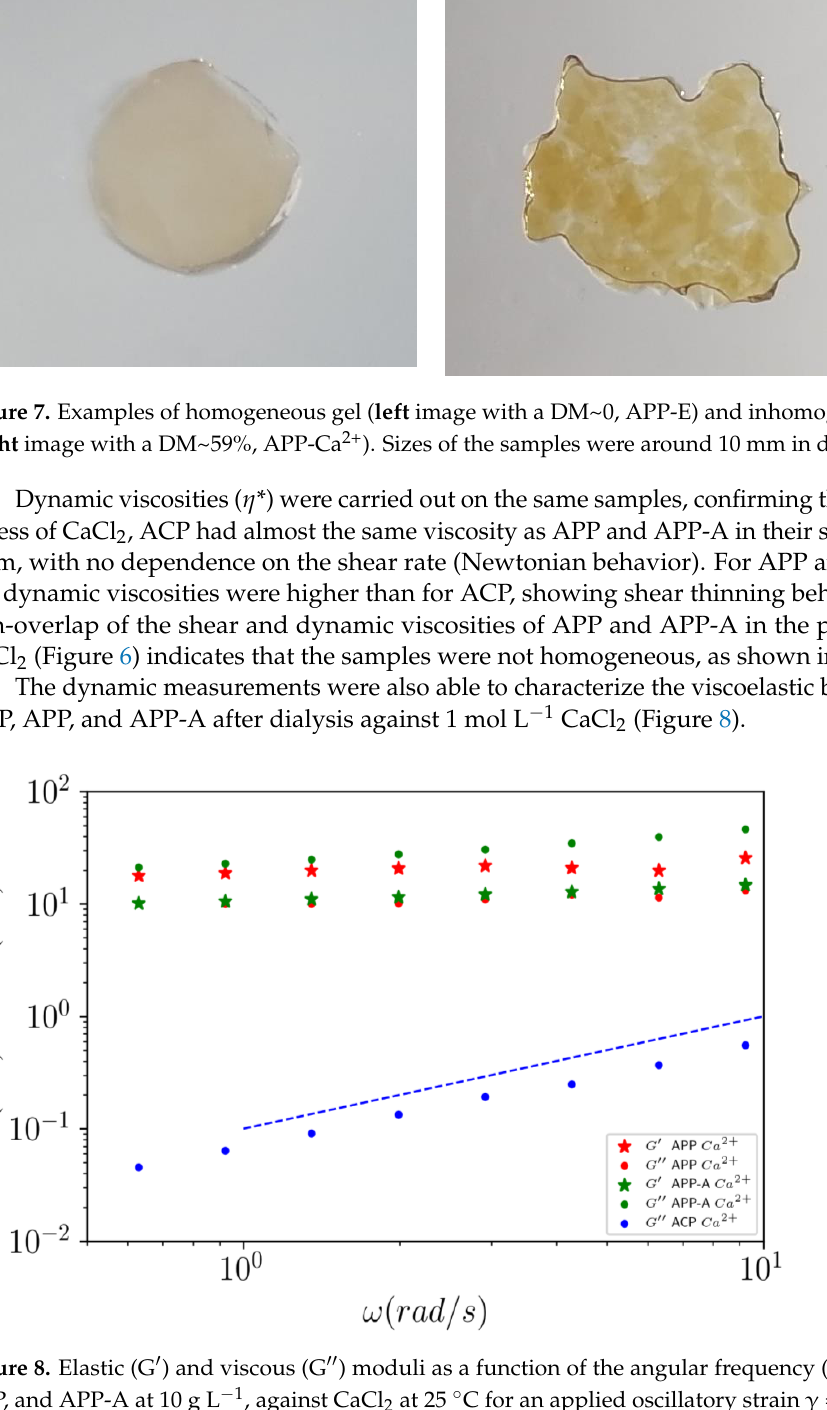
10 of 22 Figure 6. Shear (dots) and dynamic (stars) viscosity as a function of the shear rate and angular frequency, respectively, for ACP, APP, and APP-A, prepared under sodium salt form at 10 g L −1 , with or without dialysis against 1 mol L − 1 CaCl 2 at 25 °C. Their behavior was compared with that of the ACP sample. Even in excess of Ca 2+ , ACP had almost the same viscosity as APP and APP-A under their sodium salt form, with no dependence on the shear rate (Newtonian behavior). A shear thinning behavior was observed for APP (red markers, DM = 59%) and APP-A (green markers, DM = 36.8%) after dialysis against 1 mol L −1 CaCl 2 . In addition, the viscosities were higher compared to the sodium salt form and decreased when the shear rate increased (shear thinning behavior), especially for APP-A with a partial demethylation. The non-linear dependence in γ